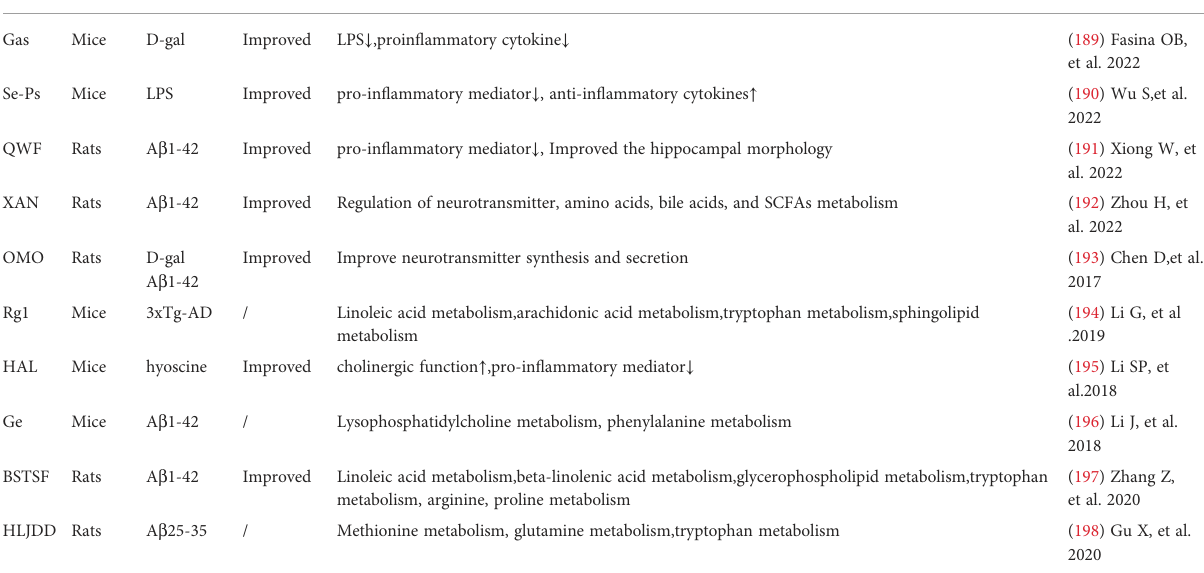
TABLE 6 TCM regulates neuroendocrine administration through the brain-gut axis.